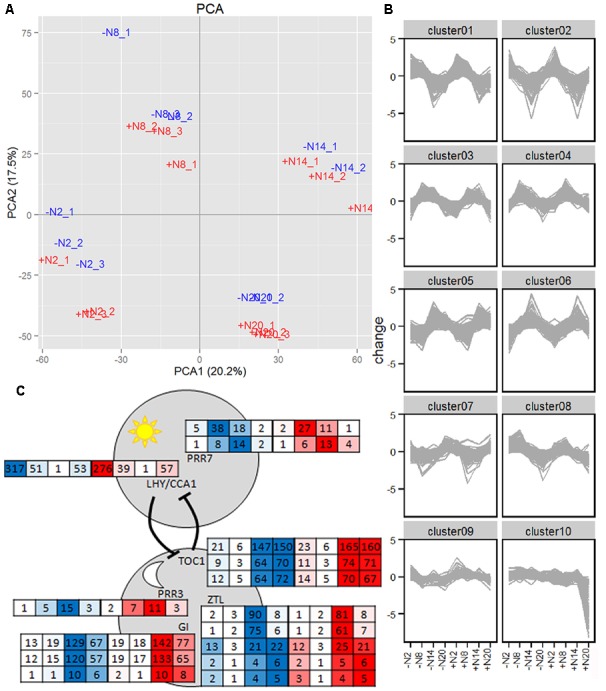
Diel transcript profiles in A. filiculoides grown with and without 2 mM NH4NO3. Ferns were acclimated to SAM without (–N, in blue) and with 2 mM NH4NO3 (+N, in red) for a week then harvested from triplicate cultures at 2, 8, 14, and 20 h with 12 h day-light starting at 6 h. RNA was extracted, sequenced and sequences analyzed as described in the section “Materials and Methods.” (A), Principal Component Analysis (PCA) and (B), K-means clustering included all genes with a read count > 10 rpm for all time points and conditions. K-means clusters were built with Pearson distance metric. (C) Clock components from the morning (above) and evening (below) loops with their respective read counts in rpm, on medium without N (in blue) and with N (in red) at 2, 8, 14, and 20 h in each box, respectively.